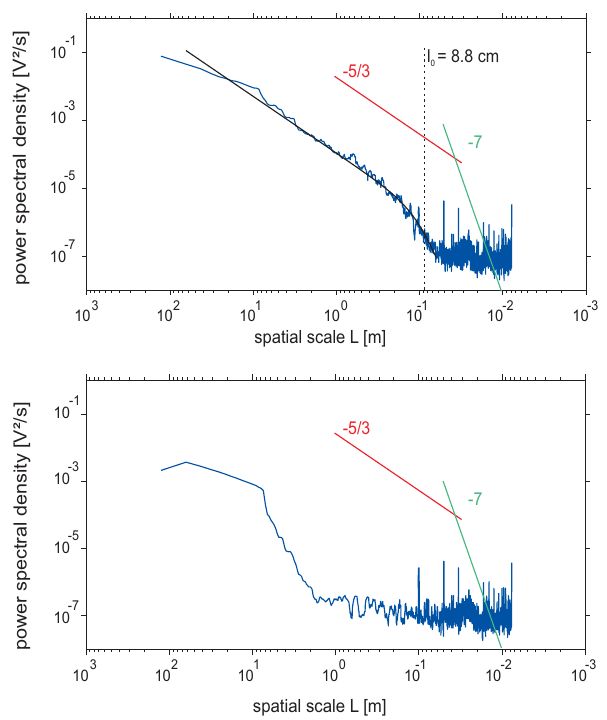
Fig. 6. Power spectrum of the voltage fluctuations for a turbulent re- gion (26550–26650m) together with the best model fit (top). Val- ues of 8.8cm for the inner scale l 0 and 29mW/kg for the energy dissipation rate ε are derived from the fit routine. The kinematic viscosity is ν = 4 . 7 × 10 − 4 m 2 /s. The spectrum of a non-turbulent region (26350–26450m) is shown for comparison